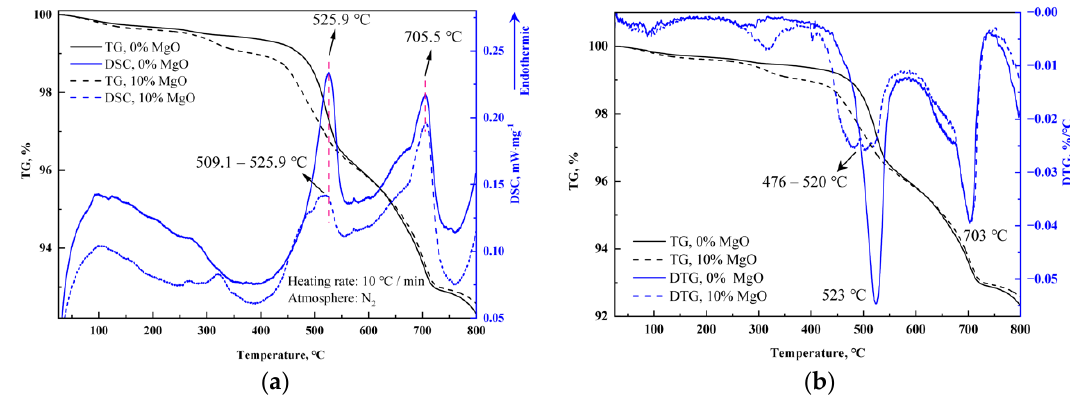
Figure 5. TG-DSC analysis of the samples without and with addition of MgO: ( a ) TG-DSC curves, ( b ) TG-DTG curves.